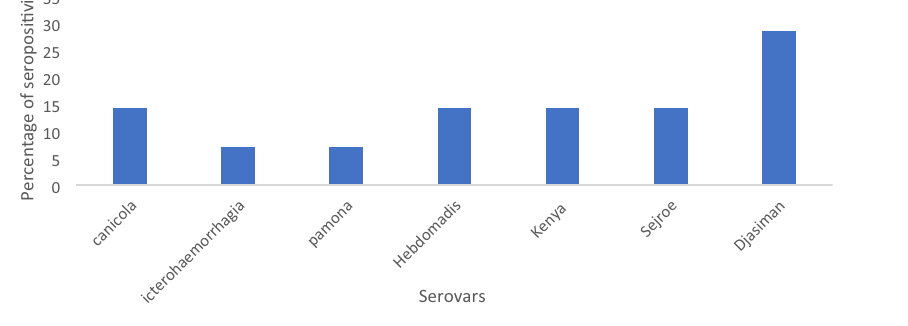
Figure 2. Prevalence of leptospira